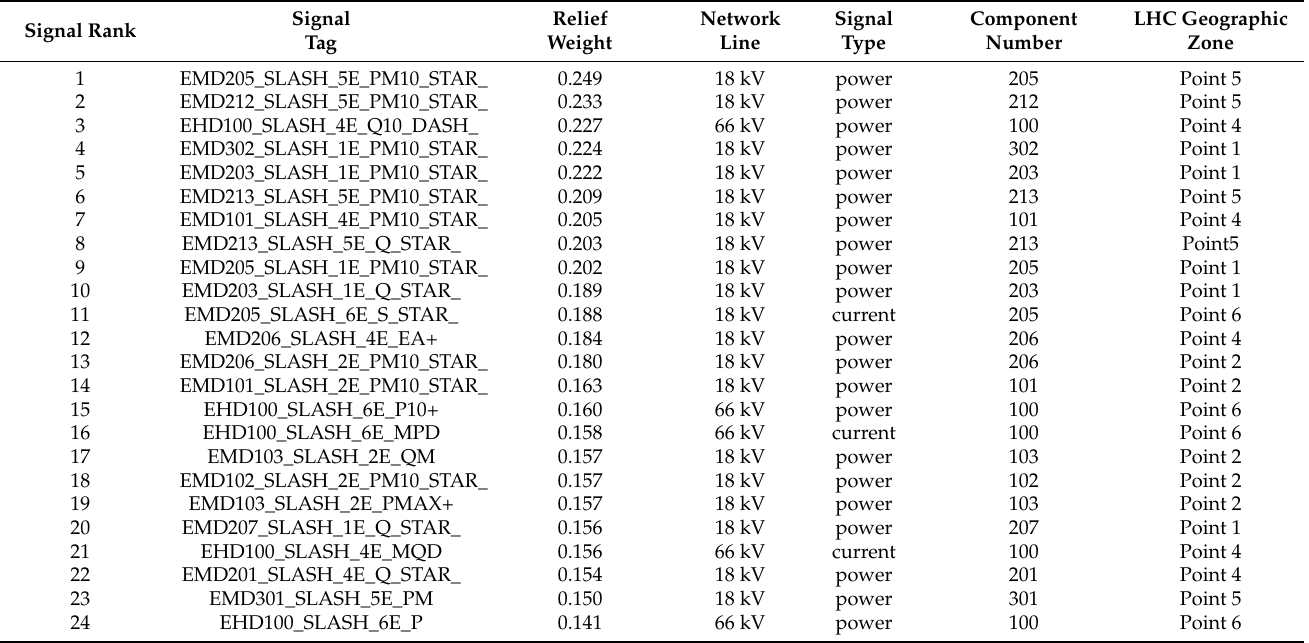
Figure 8. Performances, on the test set, of the CS-SVM classifiers built with different subsets of the Relief top-ranked features. Table 4. List of the 24 top-ranked signals by